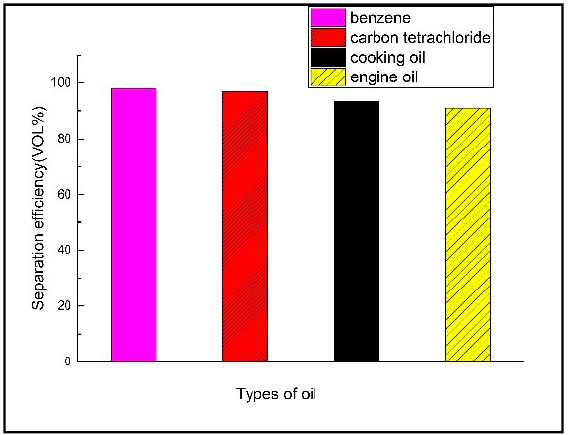
Figure 13. Separation efficiency diagram of different oil-water mixtures. Table 2. Comparison of the copper mesh membranes materials for oil/water